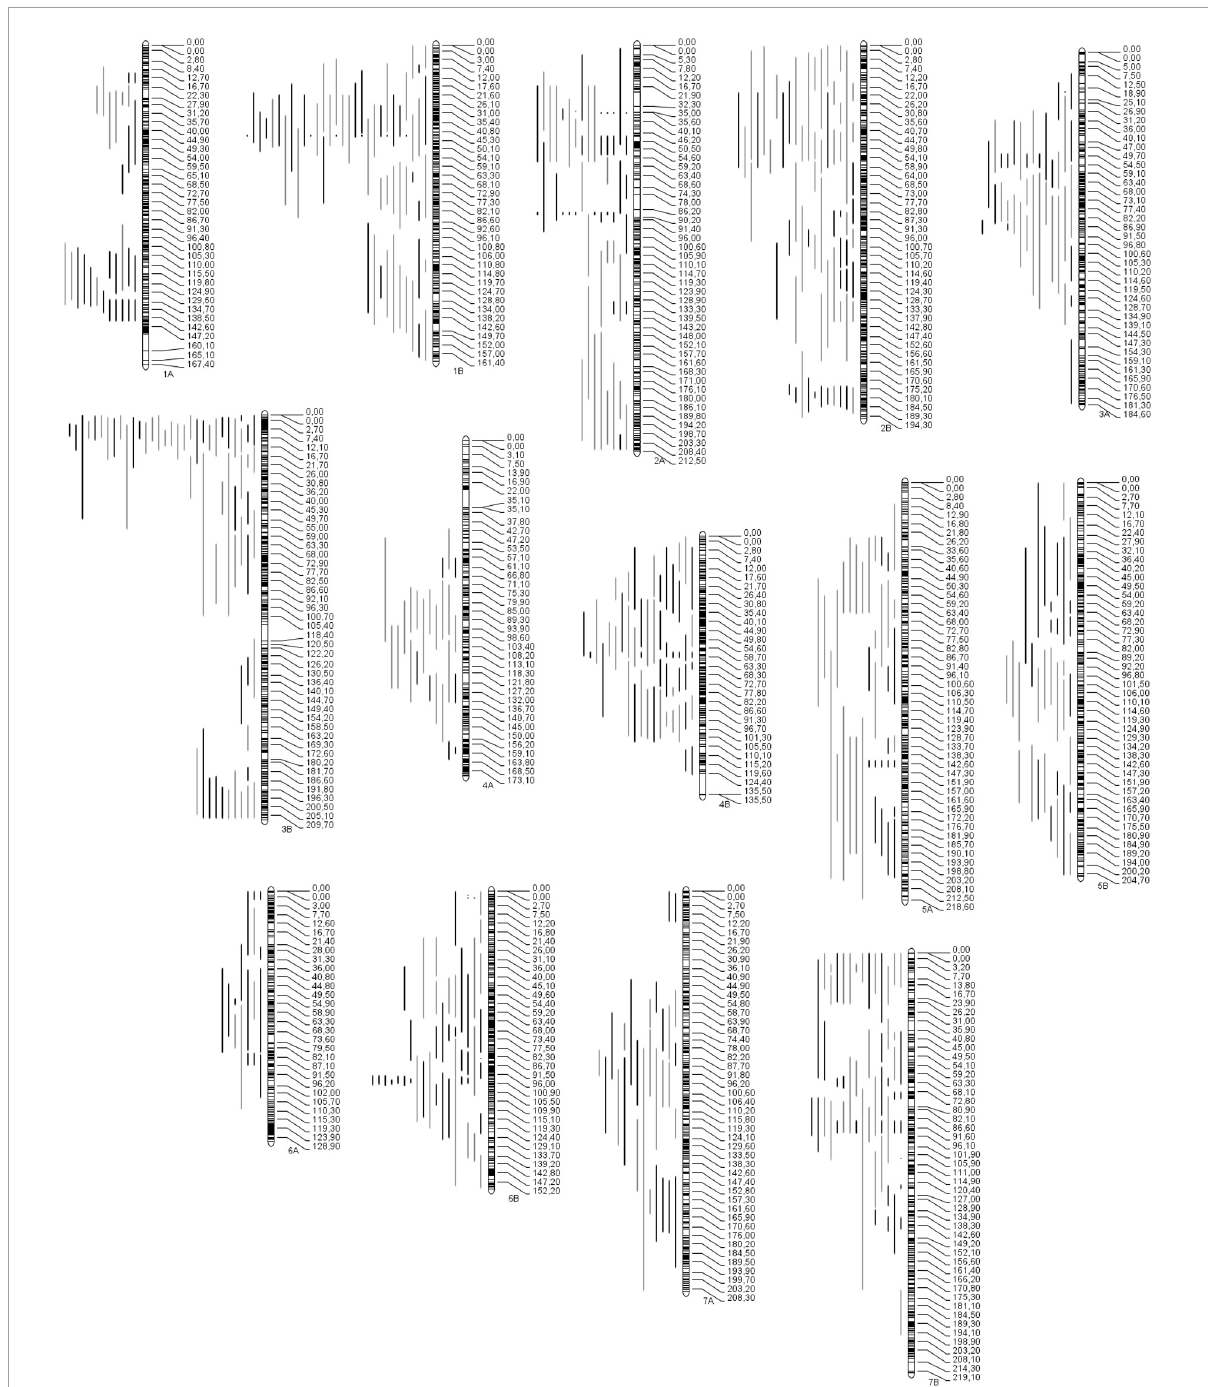
FIGURE2 Distribution of the QTL projected throughout all 14 chromosomes (genomes A and B) of durum wheat. QTL were collected for 19 traits related to the main yield components, grains number per area (gray bars) and grain weight (black bars). Black bars within chromosomes represent marker